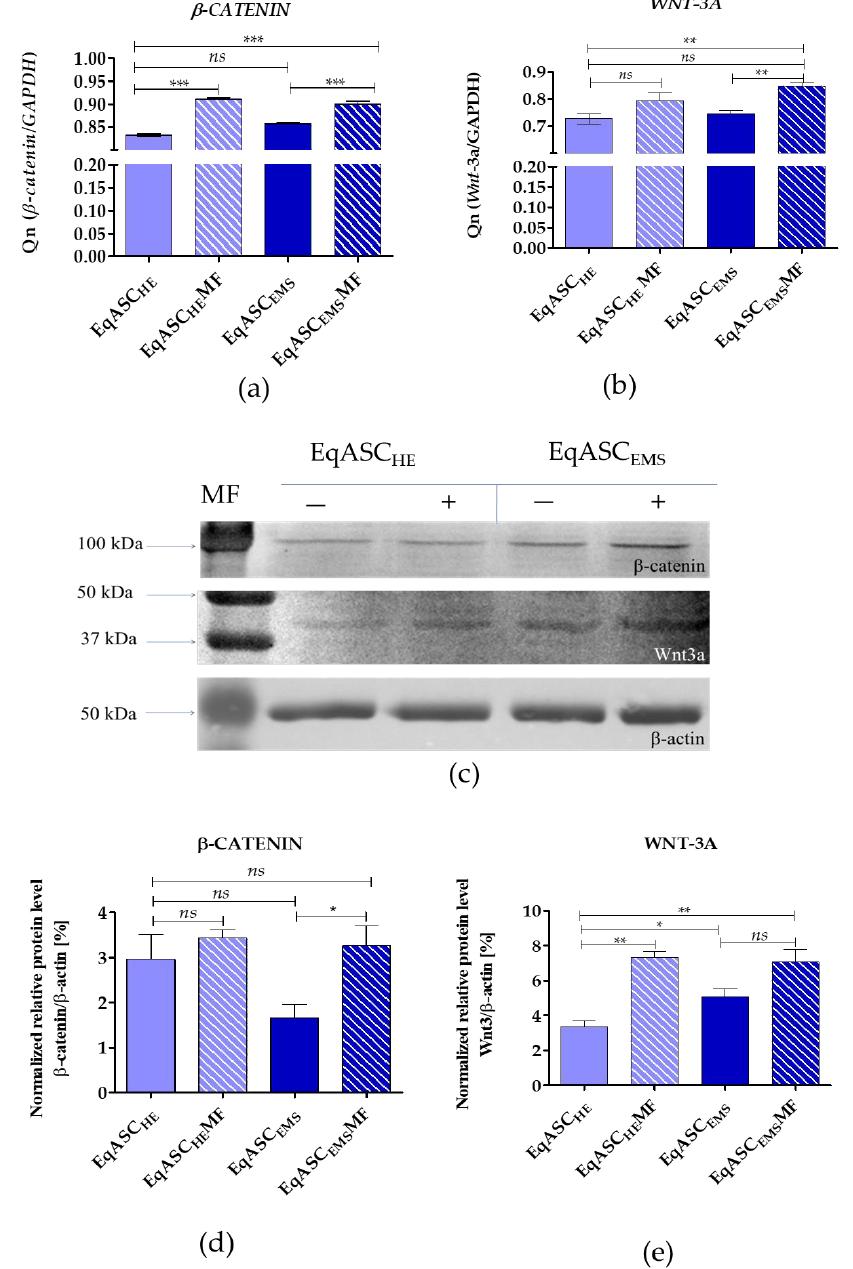
Figure 5. Determination of Wnt-3/ β -catenin expression ( a , b ) and corresponding intracellular accumulation of protein ( c – e ). Statistically significant changes are indicated with asterisks: * p < 0.05; ** p < 0.01 and *** p < 0.001, while non-significant differences are marked as ns .